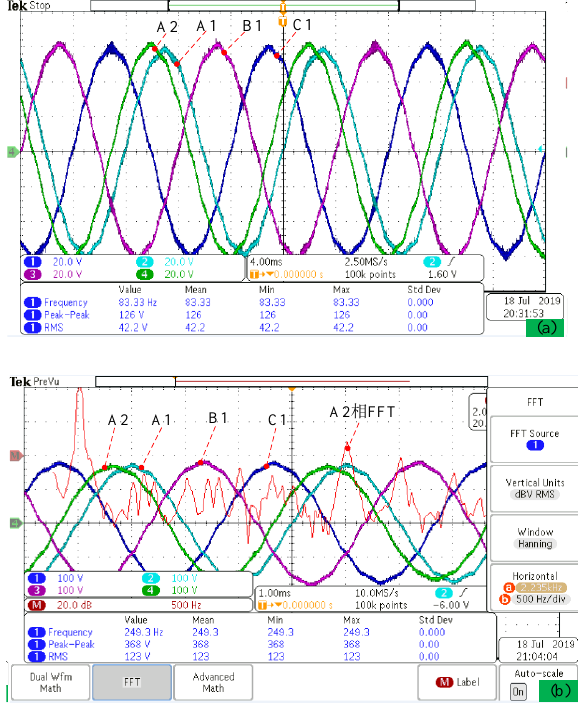
Figure 26. No-load back-EMF wave of axial-flux ISG at different speeds. ( a ) speed n = 1000 rpm, ( b ) speed n = 3000 rpm.